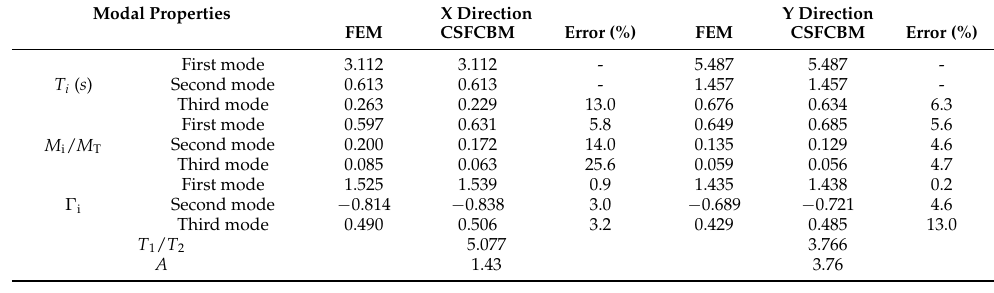
Table 3. Modal properties of building B1.